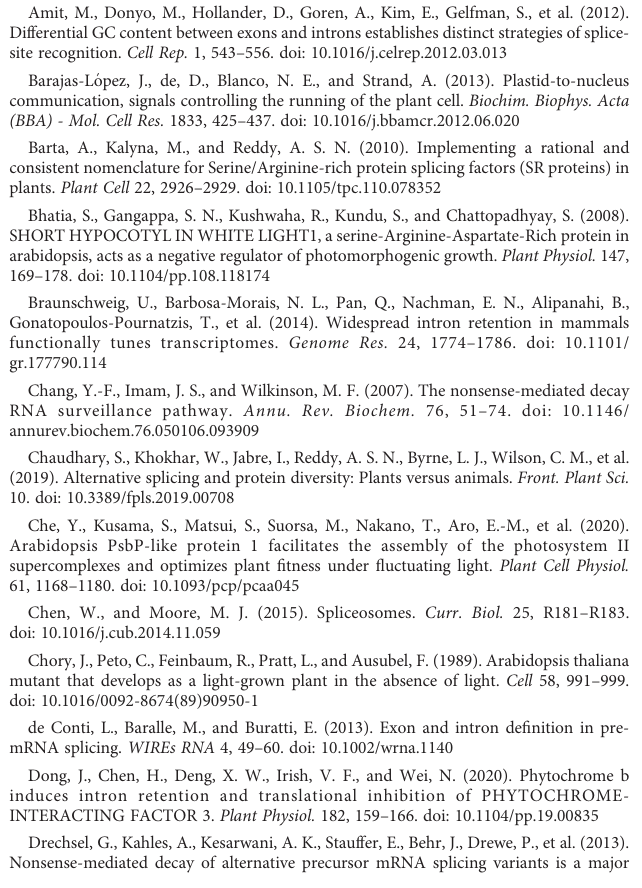
SUPPLEMENTARY TABLE 1 List of genes whose mRNA levels are differentially regulated by nor fl urazon in wild-type seedlings. Columns indicate the gene locus, name and expression values (cRPKMs) in 5-day-old wild-type (WT) and gun1 seedlings treated with nor fl urazon (NF) and untreated WTs. See Material and Methods for details on cRPKM values. SUPPLEMENTARY TABLE 2 Summary of the sequencing data used in this study. Details of the 24 samples obtained from the NCBI Short Read Archive (SRA) and used in this study. For each sample this information includes i) GEO accession number, ii) sequencing